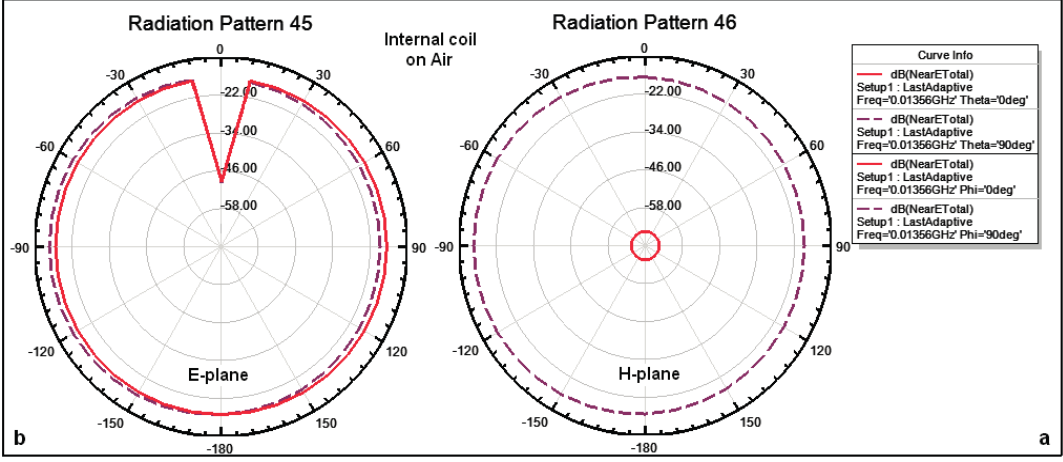
Figure 8. Simulated patterns for total near field surrounding an internal coil on air: ( a ) on the azimuthal plane ( θ = 0°, θ = 90°); ( b ) on the elevation plane ( Φ = 0°, Φ = 90°),